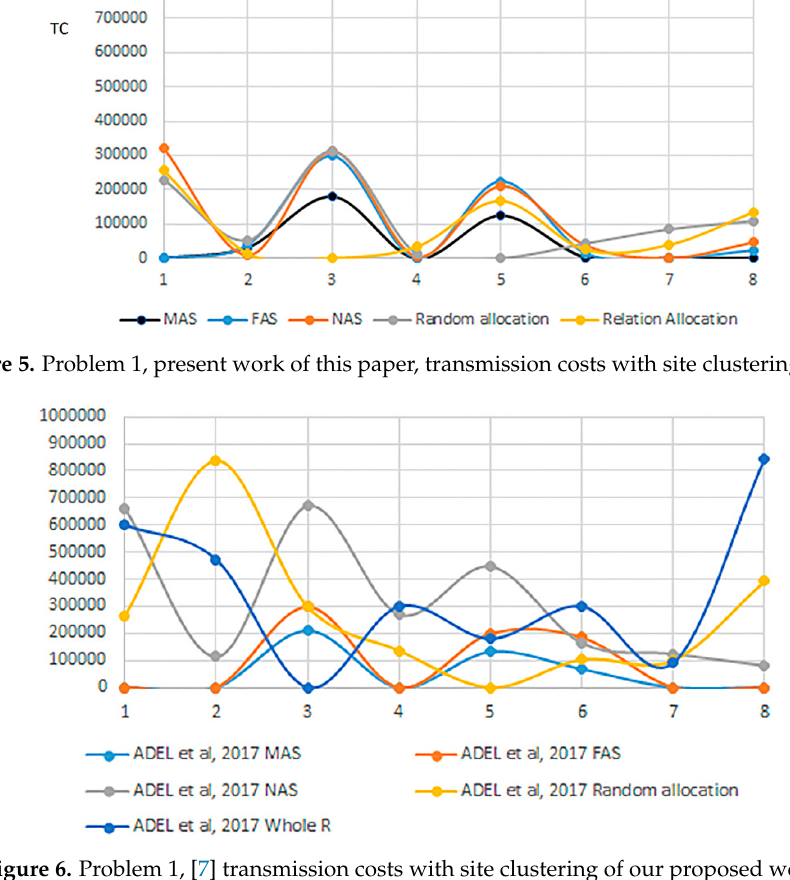
Figure 6. Problem 1, [7] transmission costs with site clustering of our proposed work